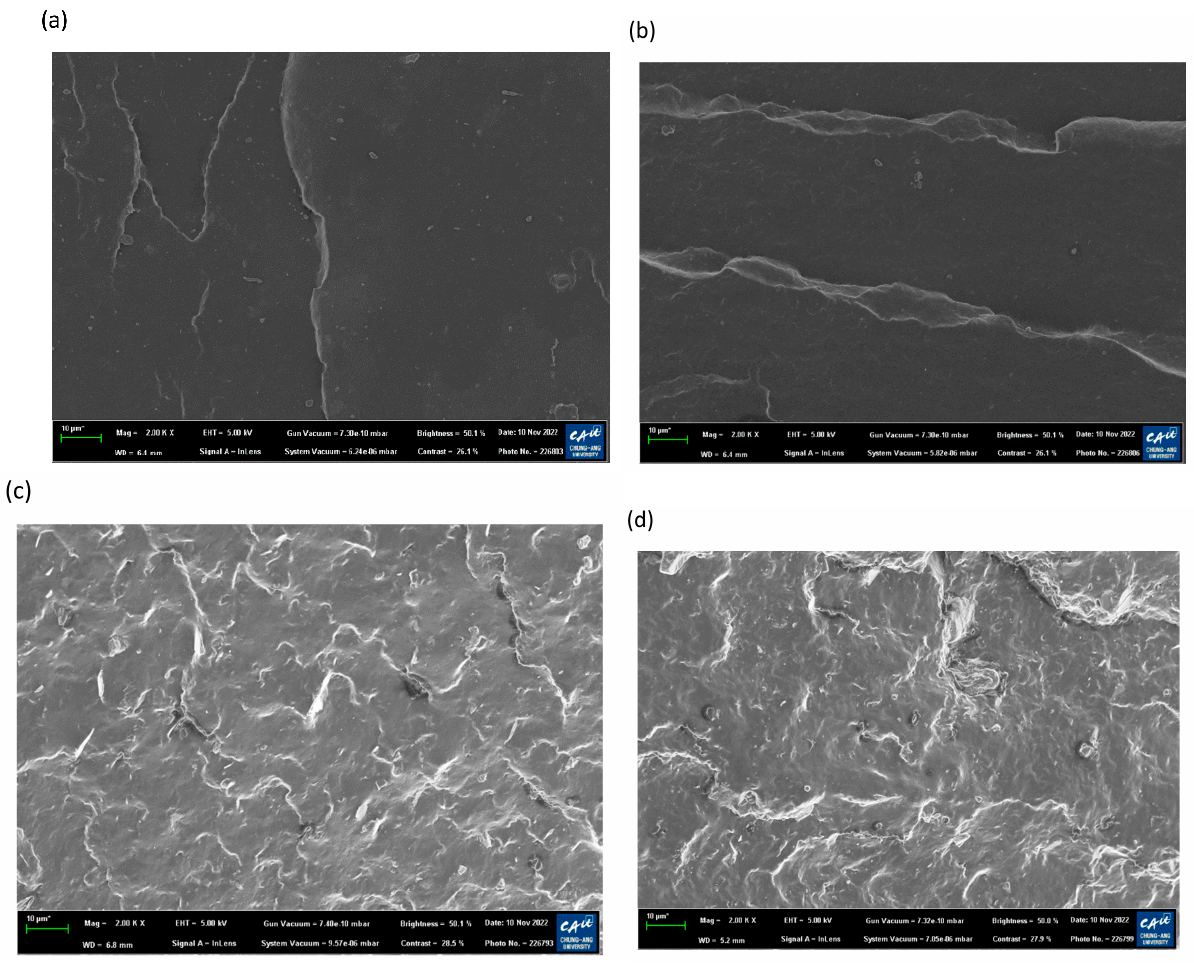
Figure 6. Surface photomicrographs of pristine and aged materials under 90 °C acidic condition; ( a ) pristine EPDM, ( b ) aged EPDM, ( c ) pristine TPV, and ( d ) aged TPV.